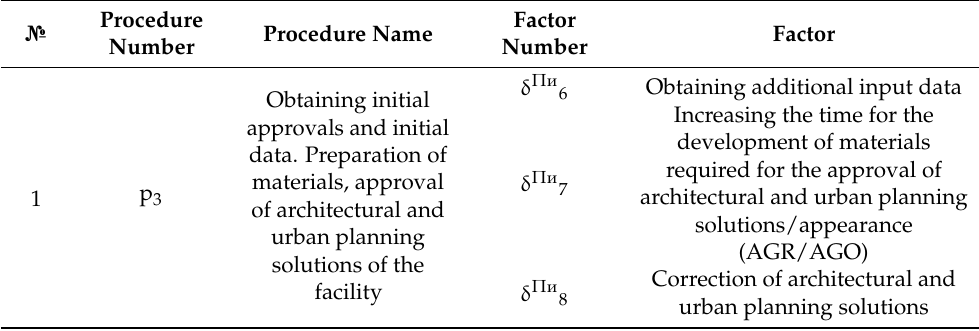
Table A4. The effect of a combination of factors on the duration of procedures at the stages of pre-project preparation and design